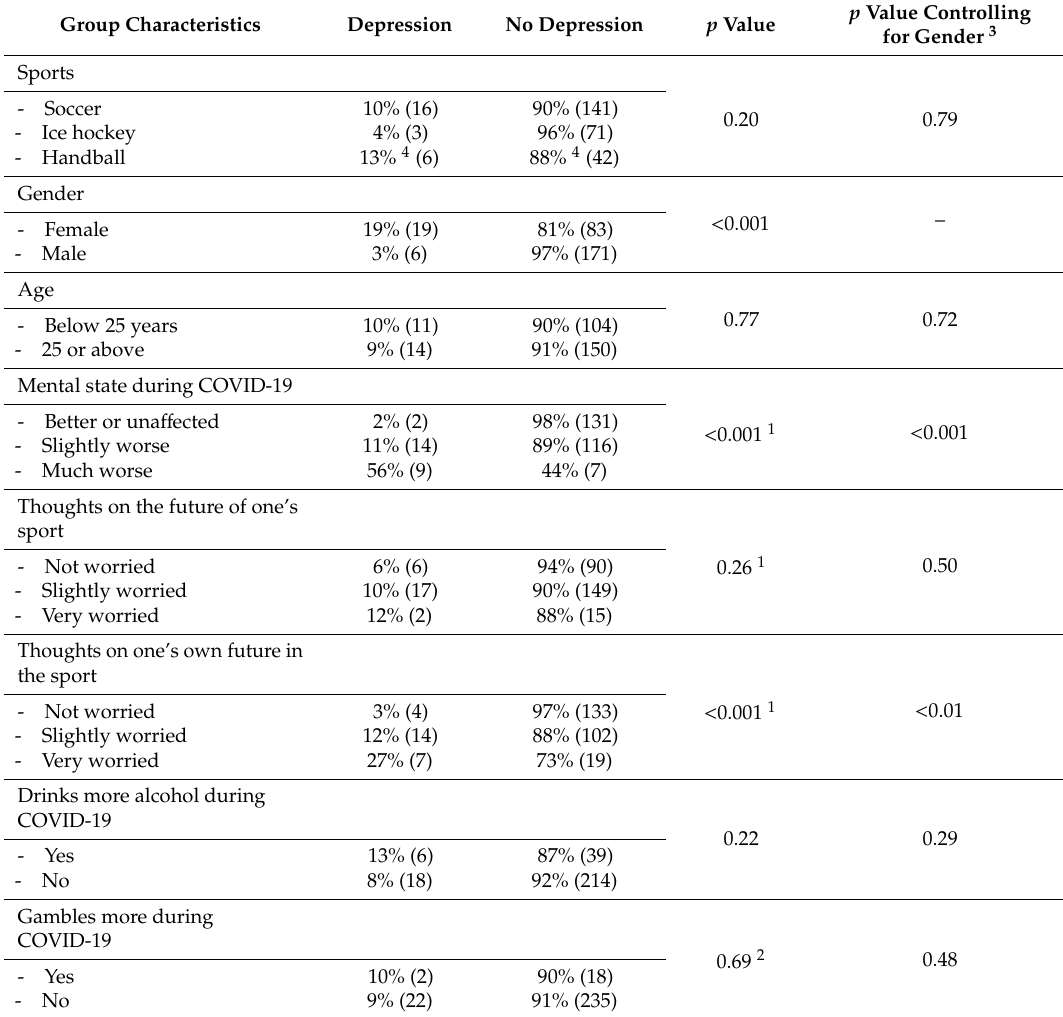
Table 3. Fulfillment of at least moderate depression symptoms (patient health questionnaire-9 score of 10 or above), depending on other variables. Chi-squared analyses for group comparisons and logistic regression analyses for the analysis of each potential correlate when controlling for gender.